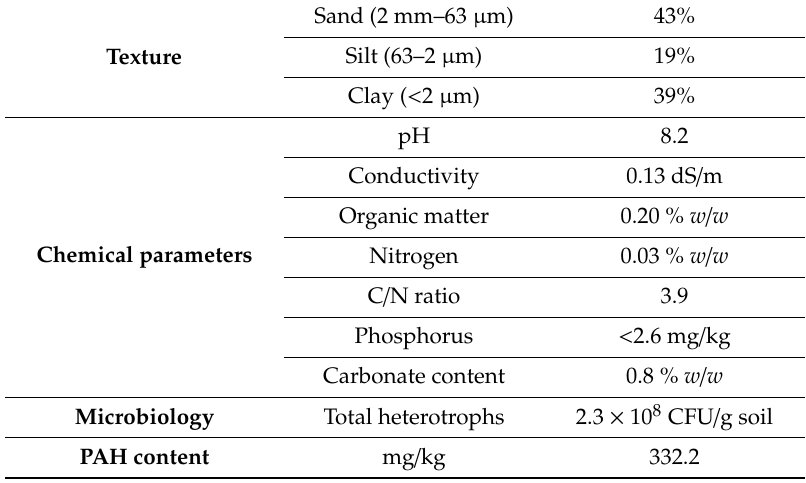
Table 2. Original soil characteristics; the values shown are an average of three measurements on distinct samples.